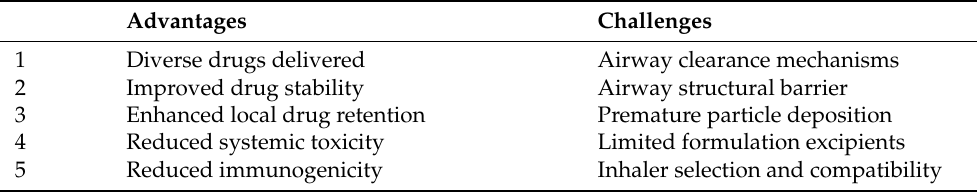
Table 1. Advantages and challenges of LNPs for inhaled therapeutics.